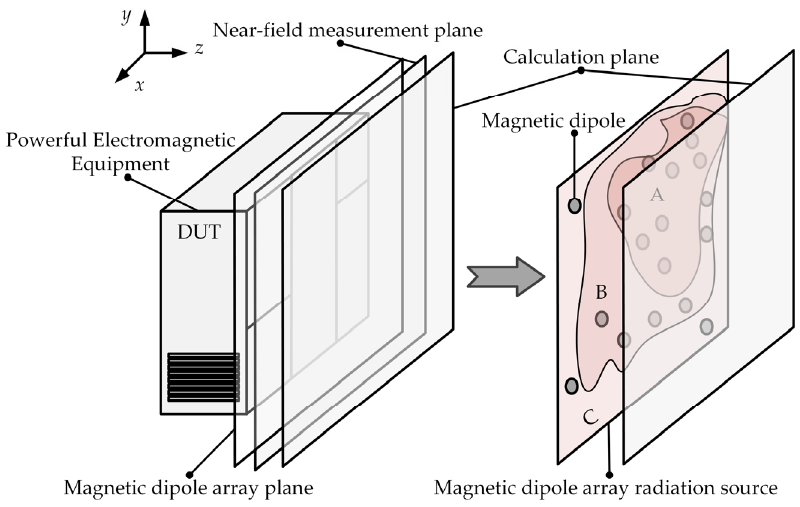
Figure 2. Schematic diagram of the equivalent dipole method. Compared with the near-field measurement plane, the magnetic dipole array plane is divided into three zones: A, B and C.